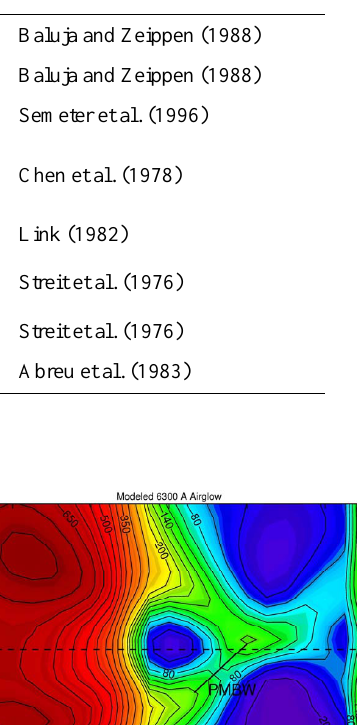
Table 1. FES airglow model parameters.